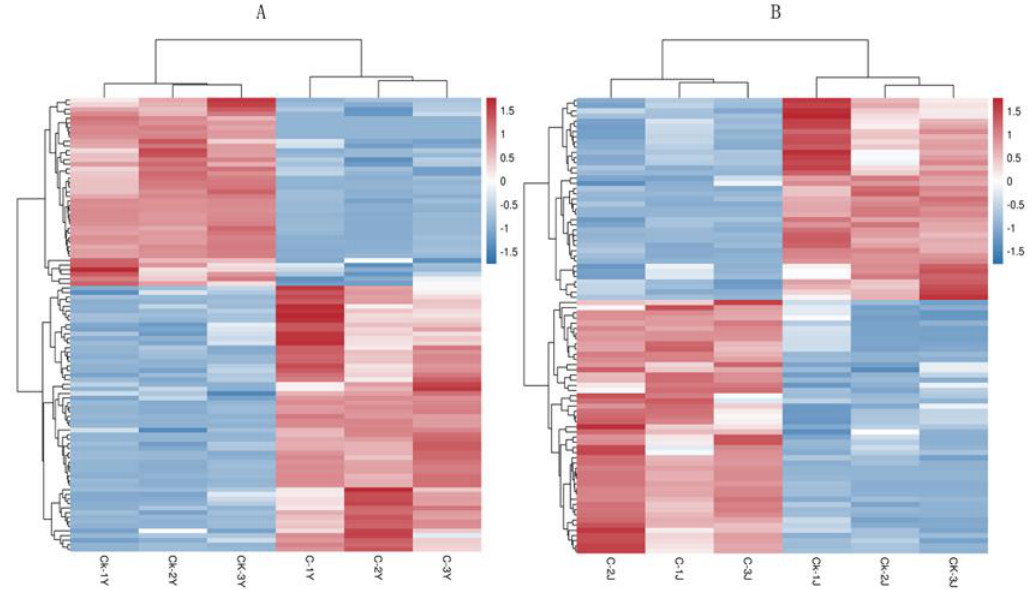
Figure 8. Heatmaps Showing Metabolite Differentiation between Treated and Control Samples. ( A ) Differential profiles of 99 metabolites in the treated (C-Y) and control (CK-Y) leaves; ( B ) differential profiles of 88 metabolites in the treated (C-J) and control (CK-J) stems. Red indicates a high abun- dance, while blue indicates a low